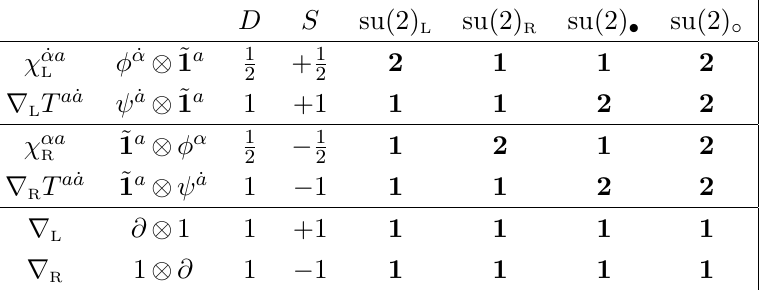
⊕ psu(1 , 1 | 2) . The L R